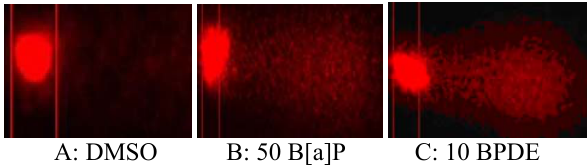
Figure 3 : Induction of the extent of DNA strand breaks by DU145 cells treated with B[a]P and BPDE. A large comet tail is visible, indicating DNA strand breaks. Panel A represents 0.1% DMSO (vehicle control). In this cell there are no detectable DNA strand breaks as indicated by the absence of a comet tail. Panel B represents a cell treated with 50 µM B[a]P. In this cell the amount of DNA strand breaks was extensive as indicated by the large comet tail. Panel C represents a cell that was treated with 10µM BPDE.